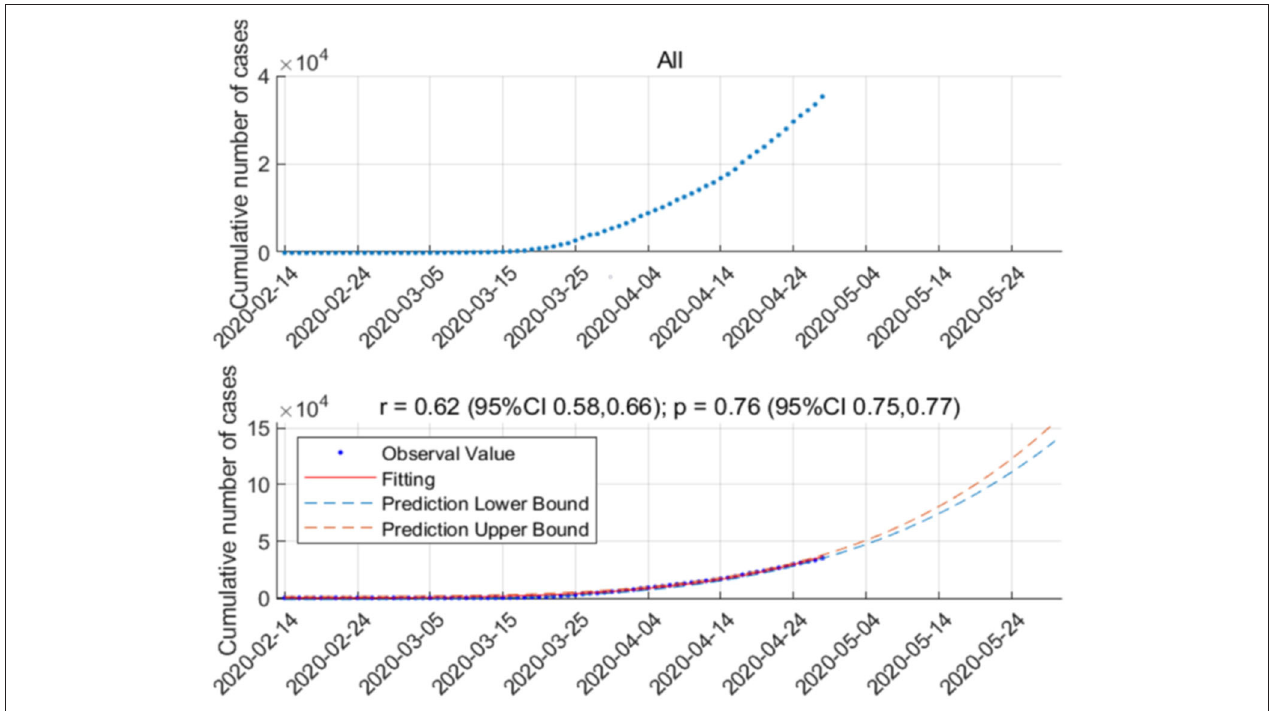
FIGURE 6 | Predictive curve of transmission dynamics of COVID-19 in Africa